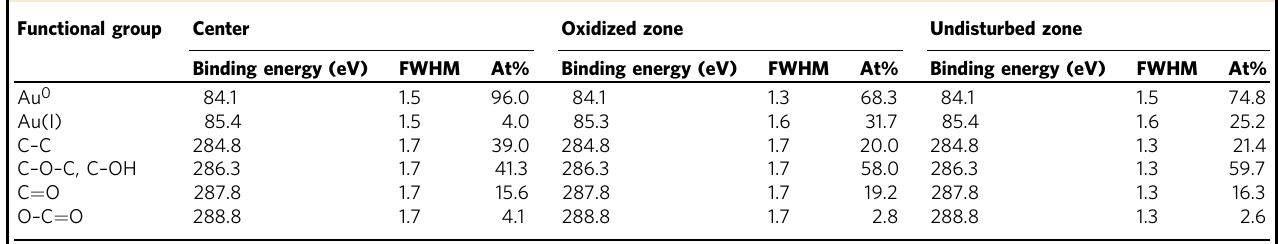
Table 2 High-resolution pro fi les of Au 4f and C 1s in each agar zone two weeks after inoculation Functional group